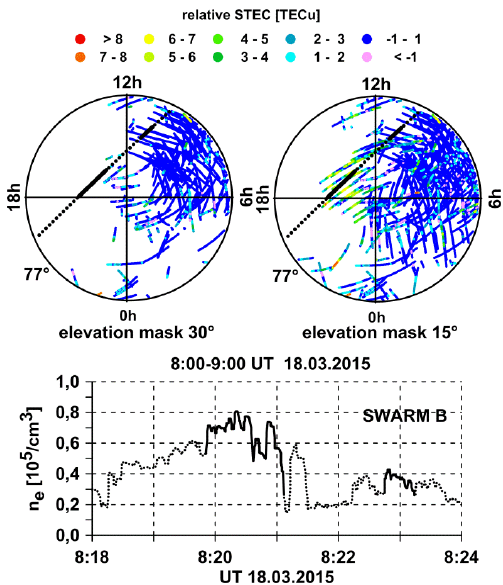
Figure 6. The signatures of patches derived from GNSS and SWARM measurements for a depleted ionosphere. The top panel presents the distribution of relative STEC values as a function of MLT and AACGM latitude for elevation masks equal to 30° and 15° with a superimposed arc of SWARM data (denoted with dotted and solid black lines). The bottom panel presents temporal profile of SWARM foreground plasma density. Black solid lines correspond to patch structures according to the Polar Cap Products (PCP) project.